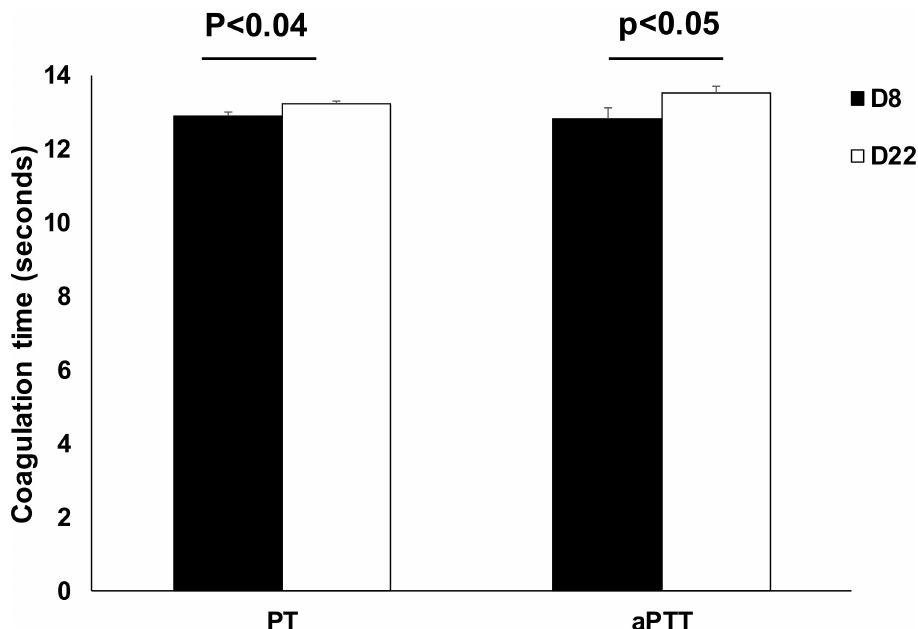
Figure 1. E ff ect of postnatal age on partial prothrombin time (PT) and activated partial thromboplastin time (aPTT). Values are means ± SEM. These data are also presented in Table 3. Data were combined by time, since treatment e ff ect was not significant. Table 3. Partial prothrombin time (PT) and activated partial thromboplastin time (aPTT) measured in the serum of piglets fed formula containing various concentrations of 6 (cid:48) -SL sodium salt on study days 8 and 22.